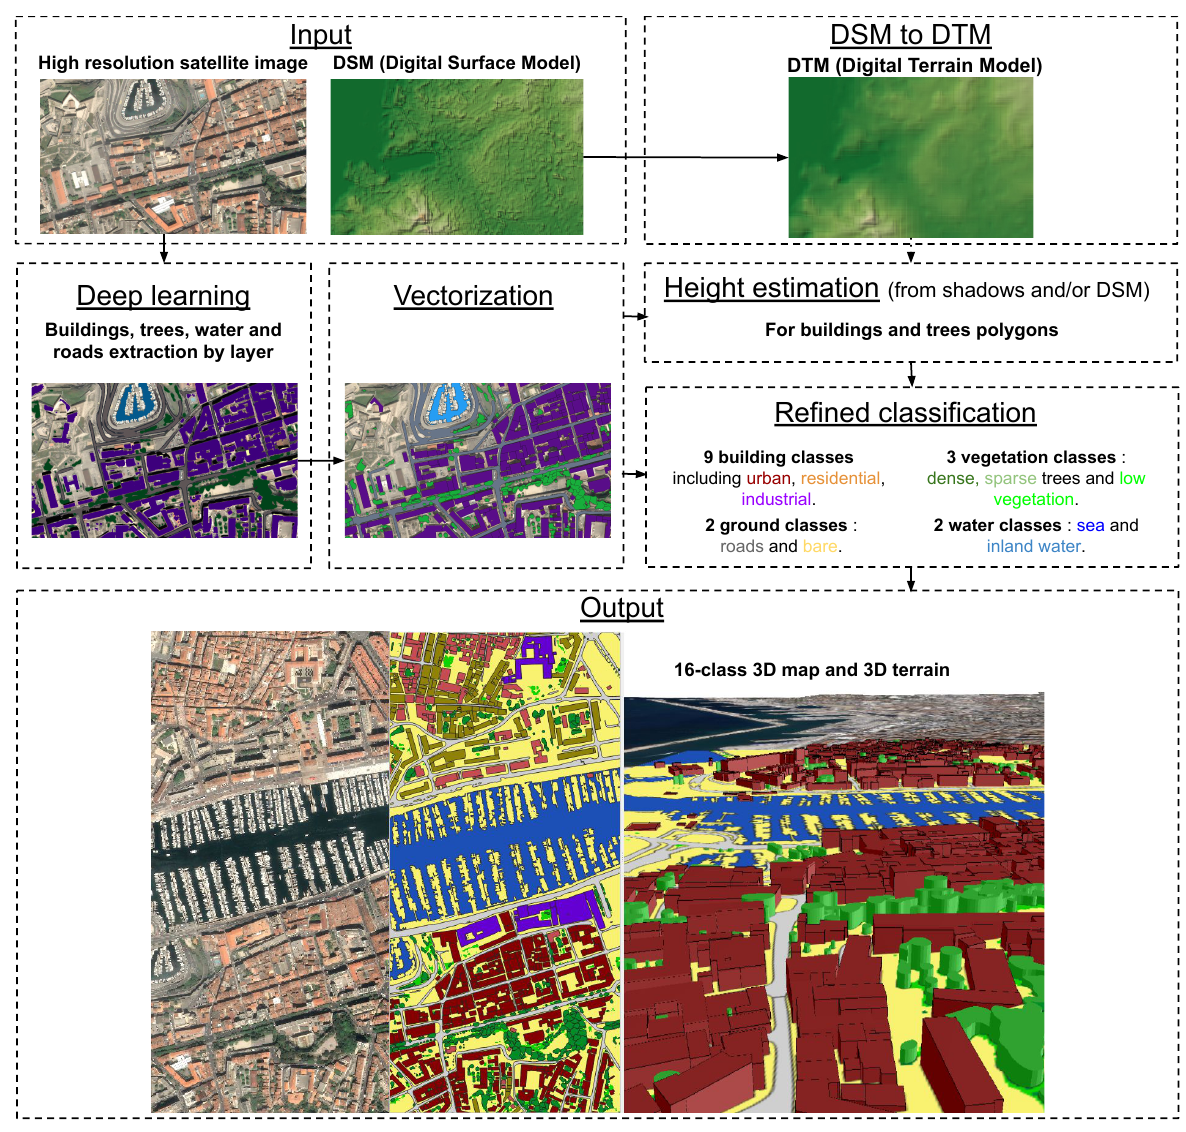
Figure 1. The proposed workflow for 3D reconstruction of urban and rural scene from one satellite image. The DSM can be used in option for height estimation, in addition to height-from-shadows algorithm (which only requires the input orthoimage); it can also be used for the estimation of the terrain height and thus the absolute height position of the